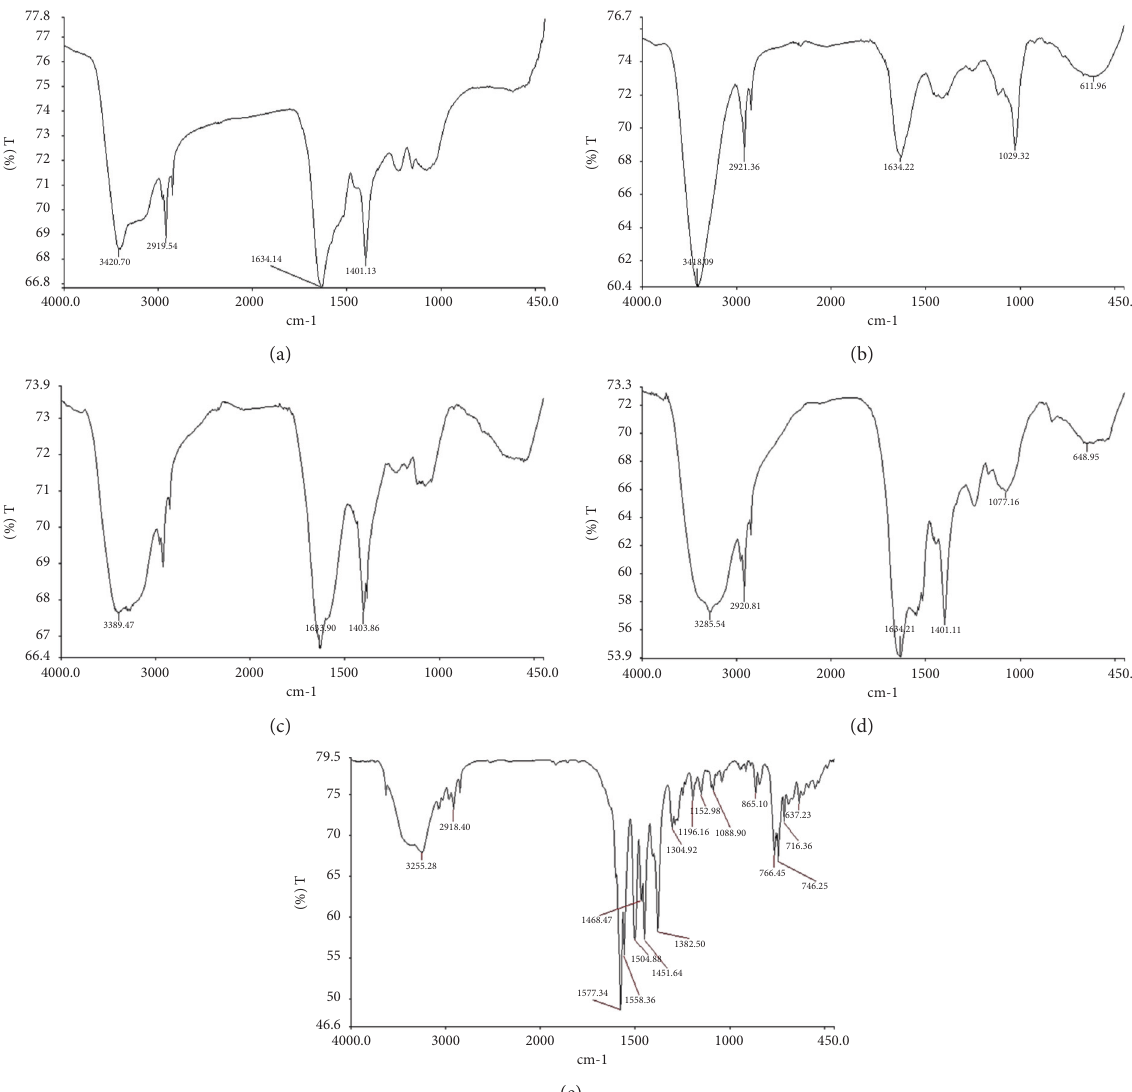
Figure 5: FTIR spectra of (a) Syzygium cumini diclofenac potassium loaded gold nanoparticles (AuNPs), (b) Ficus microcarpa diclofenac potassium loaded AuNPs, (c) Syzygium cumini diclofenac potassium loaded iron nanoparticles (FeNPs), (d) Ficus microcarpa diclofenac potassium loaded FeNPs, (e) diclofenac potassium